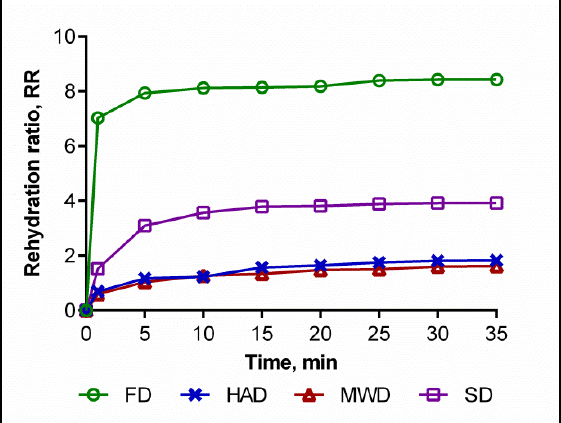
Figure 3. Rehydration curves of dried oyster mushrooms at distinct time. FD—freeze drying; HAD—hot air drying; MWD—microwave drying; SD—sun drying.